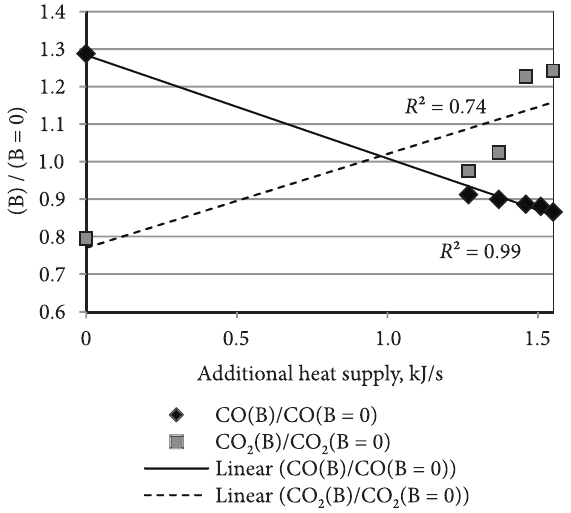
Fig. 12. Influence of propane-butane supply on T(B)/T (B = 0) and NO (B)/NO (B = 0) ratio x x